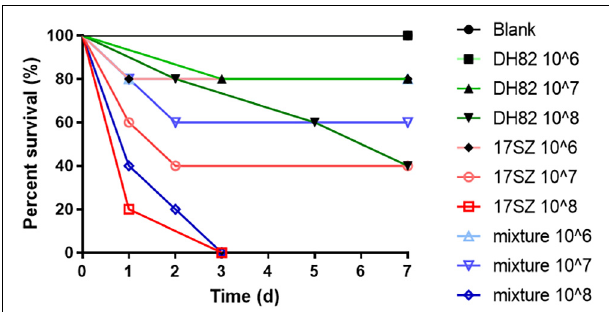
FIGURE 7 | Survival rate of shrimps after injection challenge. Fifty shrimps were randomly allocated to 10 groups, respectively injected at the muscle between 5th and 6th uromere with 1 mL of 17SZ and DH82, and the same volume of the mixture (1:1) of 17SZ and DH82 at different doses, compared with the blank of injection with PBS as control. The survival rates of each • treatment are presented: the blank is presented by in black line; DH82 at a dose of 10 6 CFU/mL is presented by (cid:4) in light green line, 10 7 CFU/mL by (cid:78) in green line, DH82 at 10 8 CFU/mL by (cid:78) in dark green line; 17SZ at ◦ 10 6 CFU/mL by (cid:4) in pink line, 10 7 CFU/mL by in light red line, 10 8 CFU/mL by (cid:3) in red line; mixture at 10 6 CFU/mL by (cid:52) in light blue line, 10 7 CFU/mL by (cid:52) in light purple line, 10 8 CFU/mL by (cid:3) in blue line.